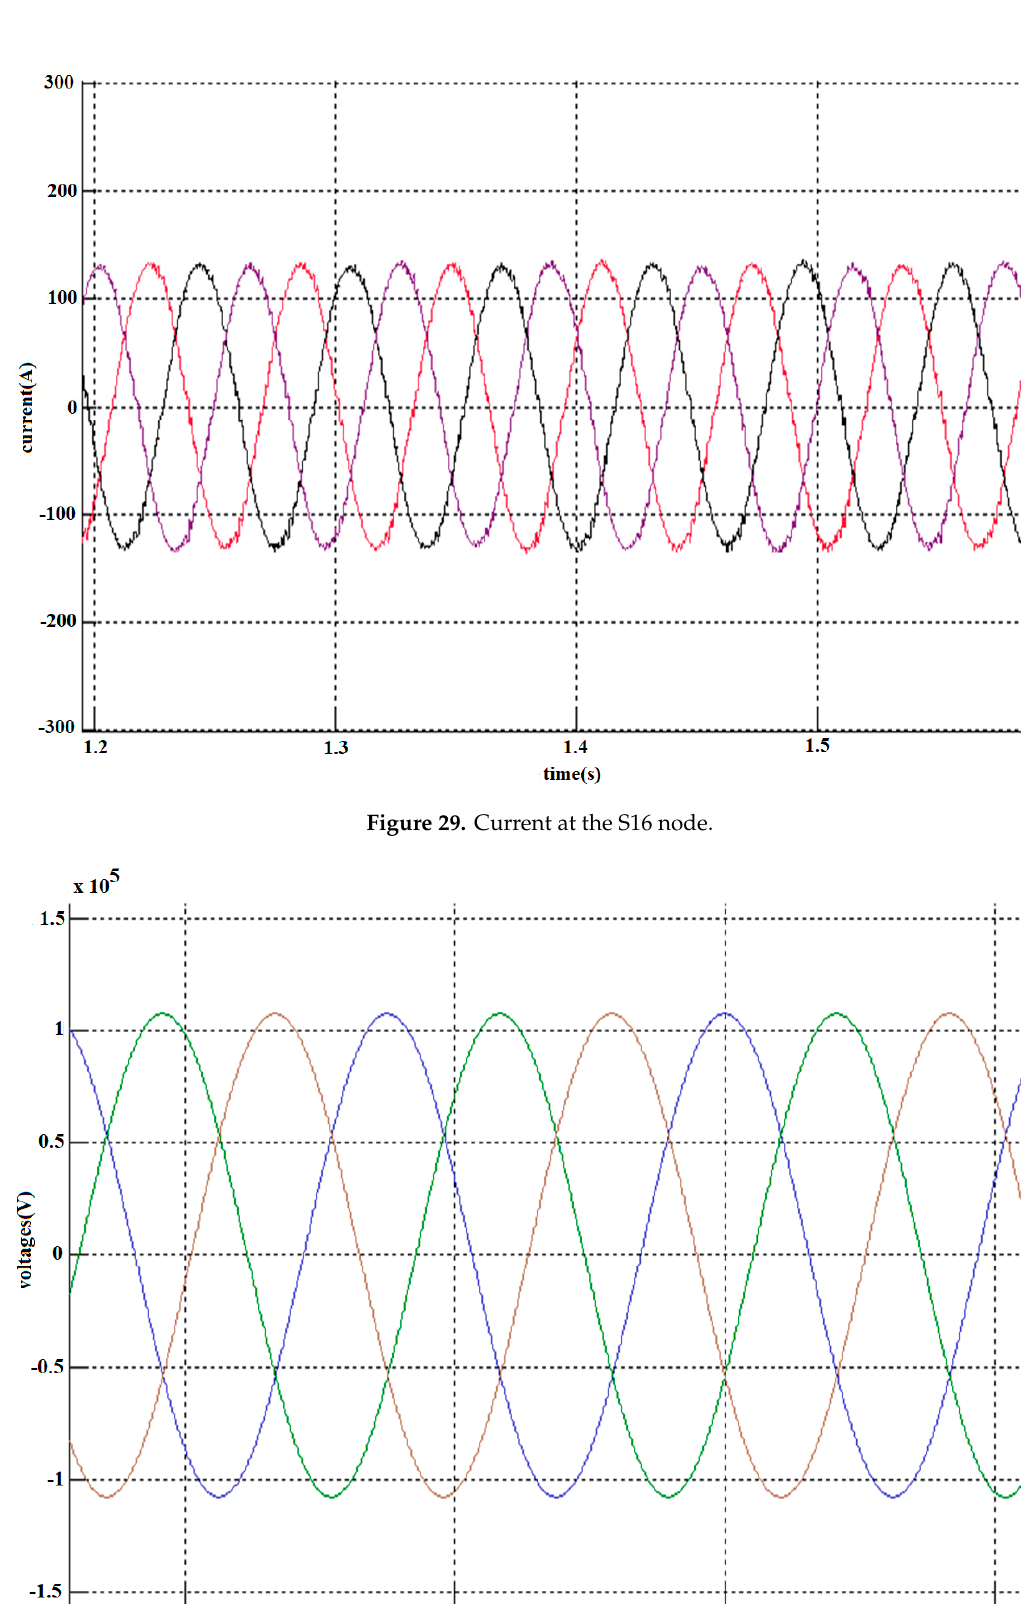
Figure 31. Active and reactive power at the S16 node (16 Hz).